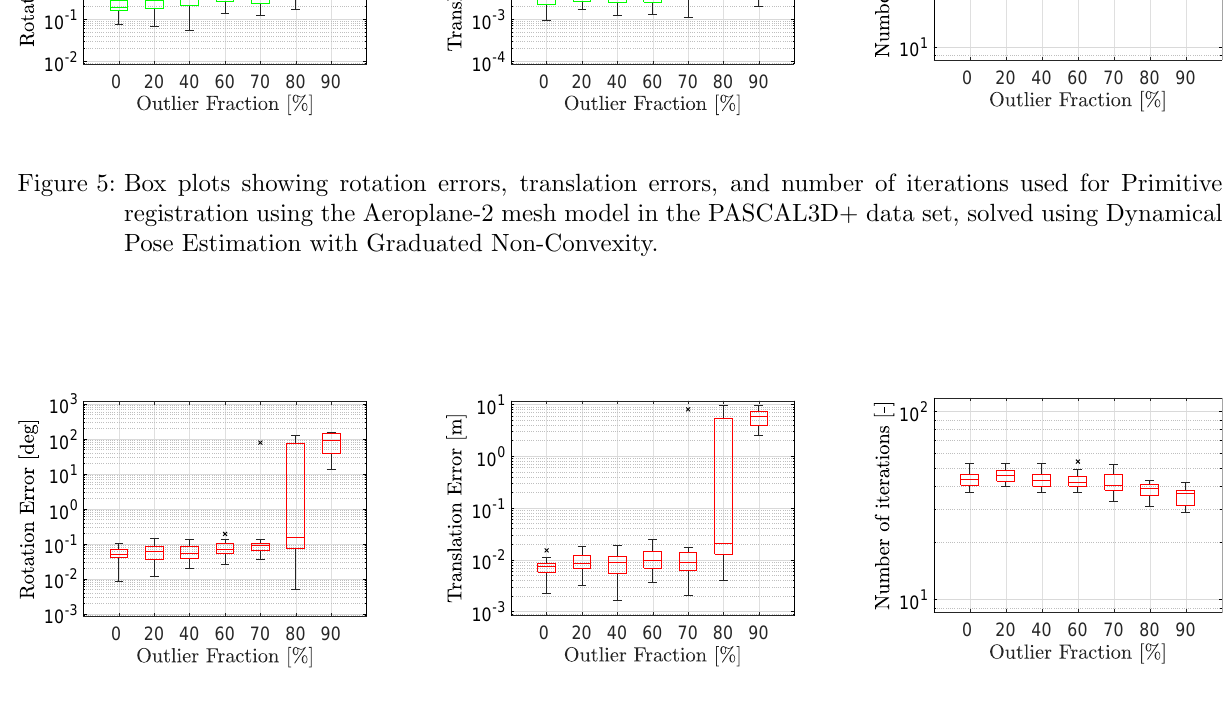
Figure 6: Box plots showing rotation errors, translation errors, and number of iterations used for Absolute pose estimation using a synthetic sample problem, solved using Dynamical Pose Estimation with Graduated